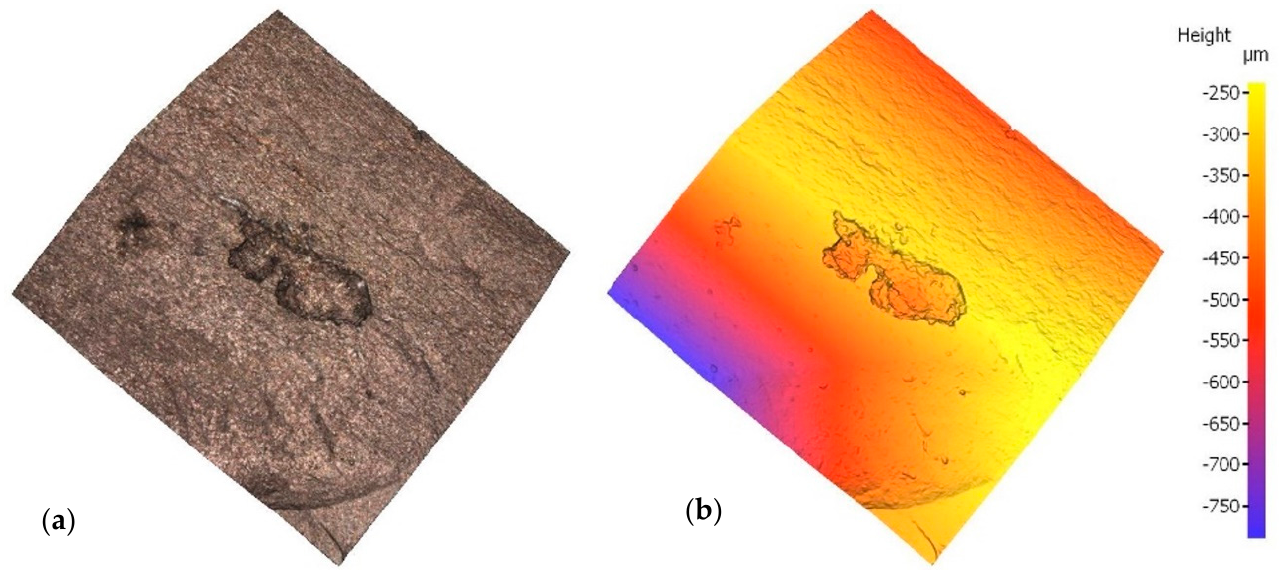
Figure 4. Pit in specimen E21: ( a ) natural colour; ( b ) depth-based colour coding.